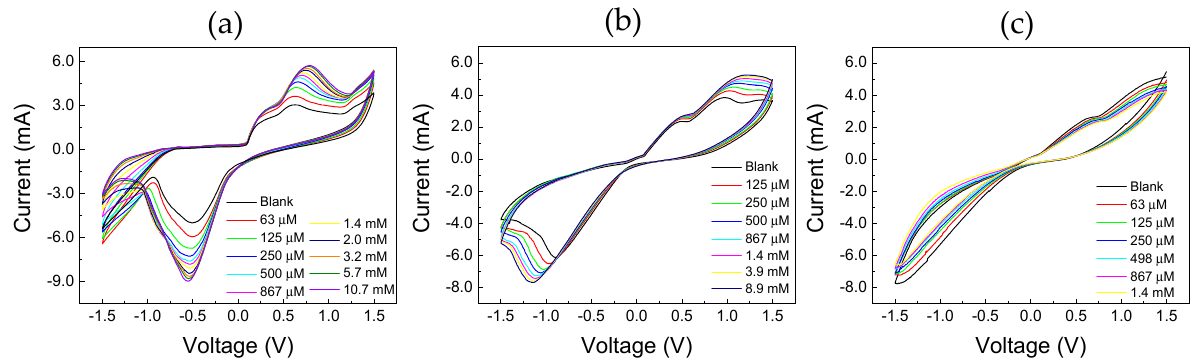
Figure 5. Three series of CV obtained, with increasing proline concentration between 63 µ mol L − 1 and 10.7 mmol L − 1 , using three different fixed concentrations of hydrogen peroxide in PBS and KCl solution: ( a ) 1.5 mmol L − 1 , ( b ) 11.1 mmol L − 1 , ( c ) 16.7 mmol L − 1 of H 2 O 2 , respectively.